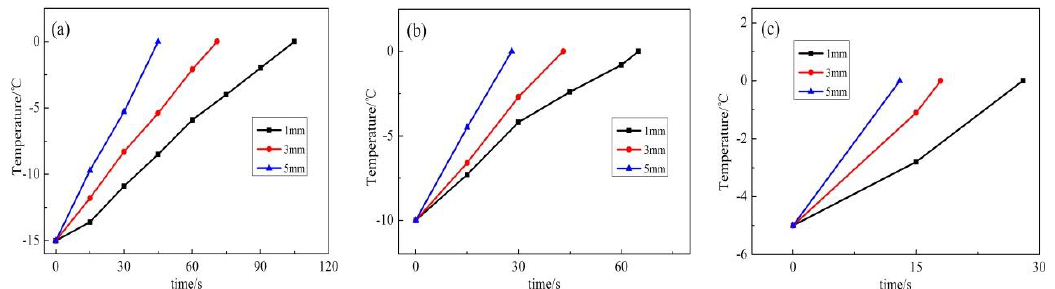
Figure 14. The influence of lengths of steel wool fiber and ambient temperature on deicing temperature. ( a ) −15 °C; ( b ) −10